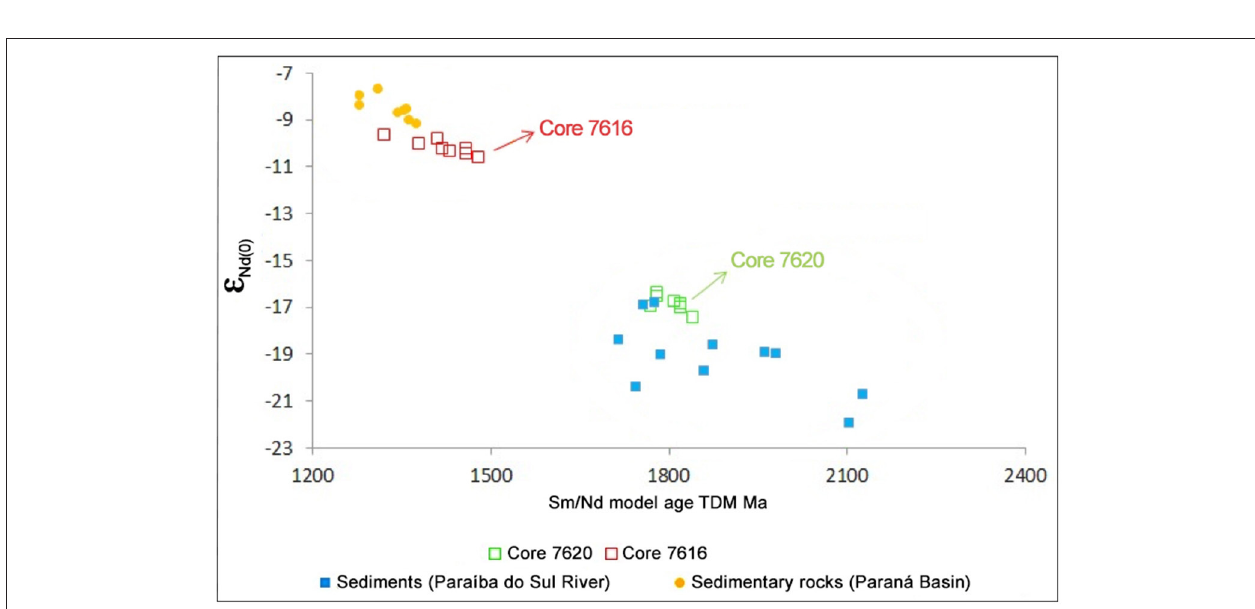
FIGURE 4 | Diagram of ε Nd(0) vs. Sm/Nd model age (T DM ) (Ma): showing the comparison between isotopic signatures of the Core 7616 and sedimentary rocks from the Paraná basin, and the Core 7620 and sediments from the Paraíba do Sul River.